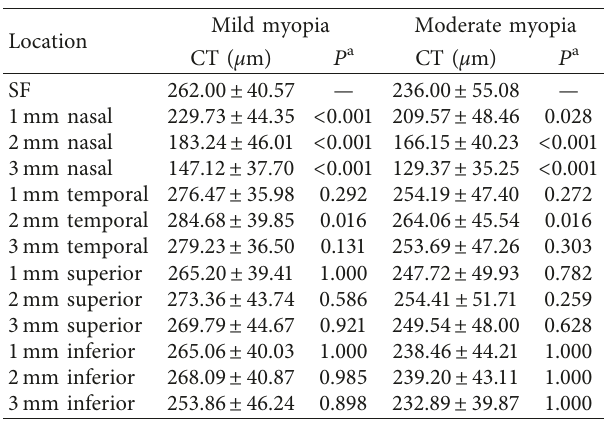
Table 2: Choroidal thickness of different measured locations and comparison between choroidal thickness of different measured locations and subfoveal choroidal thickness in two refraction groups.